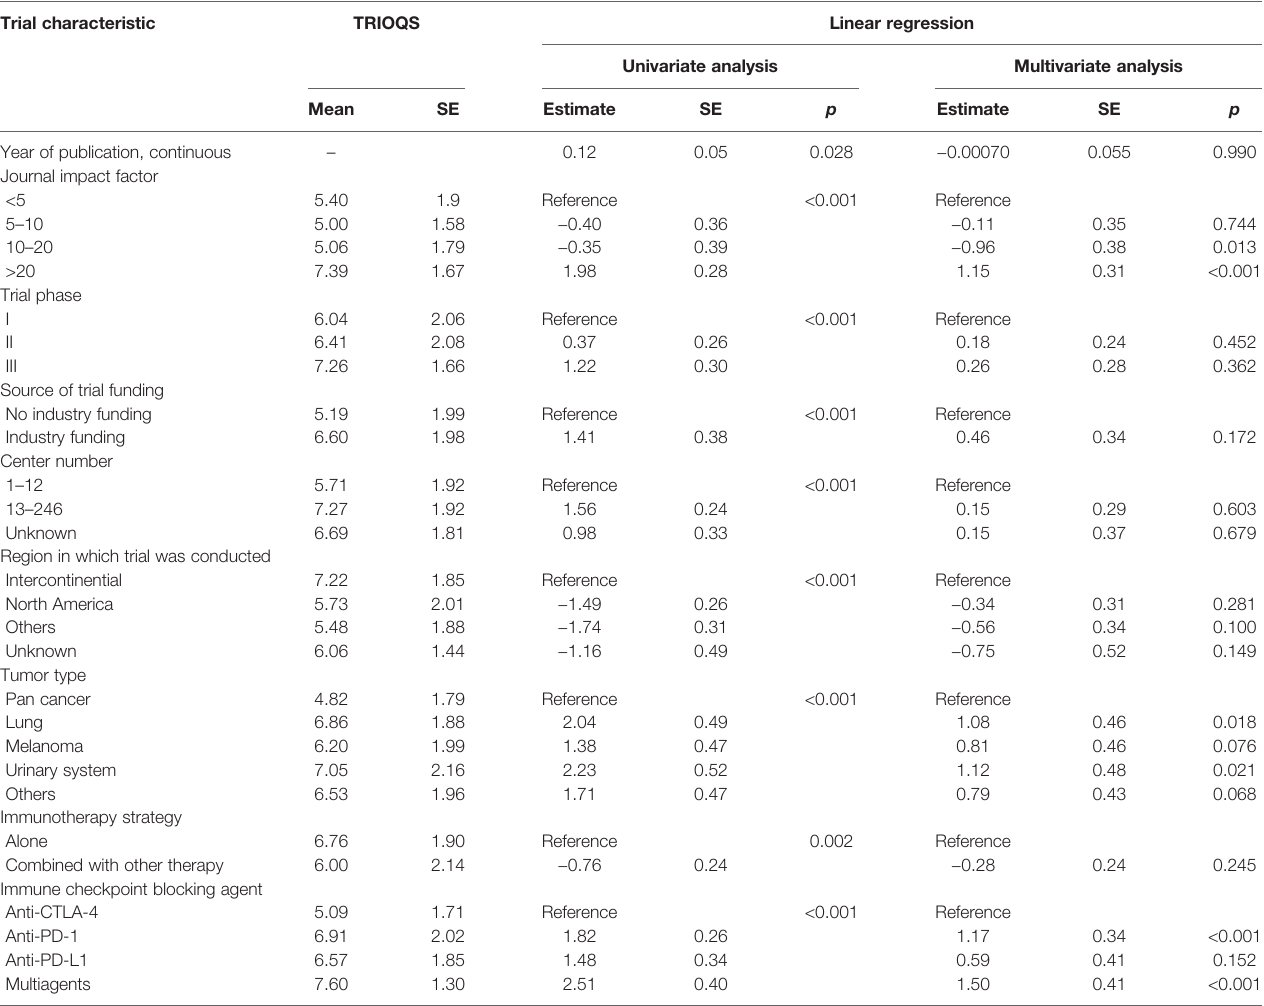
TABLE 3 | Results of linear regression analyses of trial characteristics predicting TRIOQS (0-11 scale). Trial